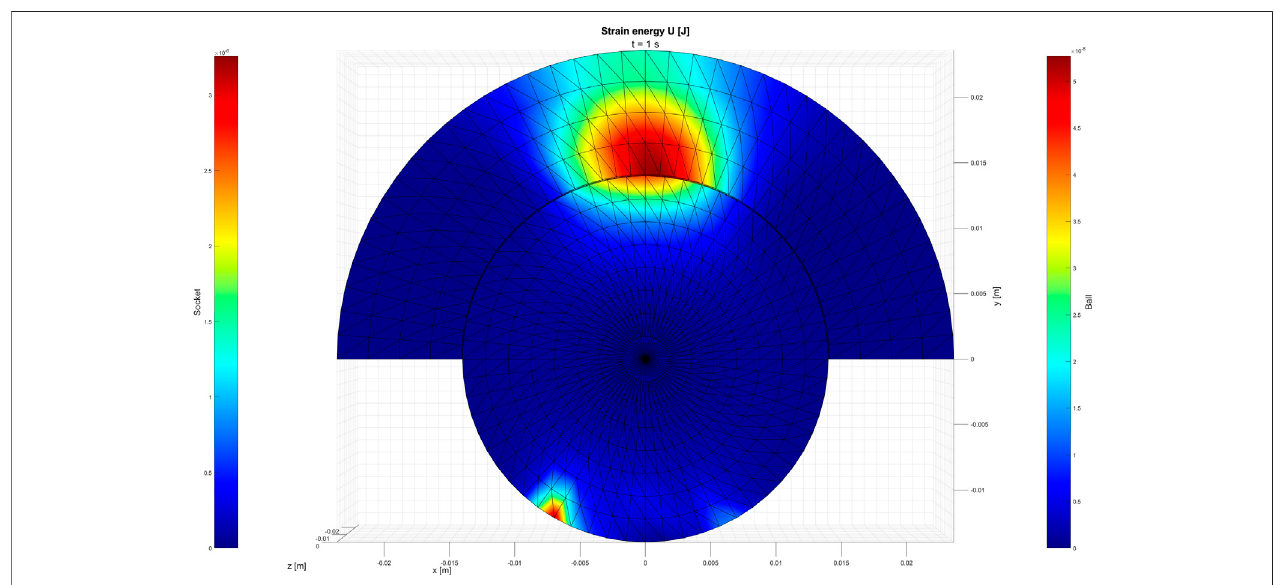
FIGURE 14 | Strain energy fi eld inside of the spherical joint.